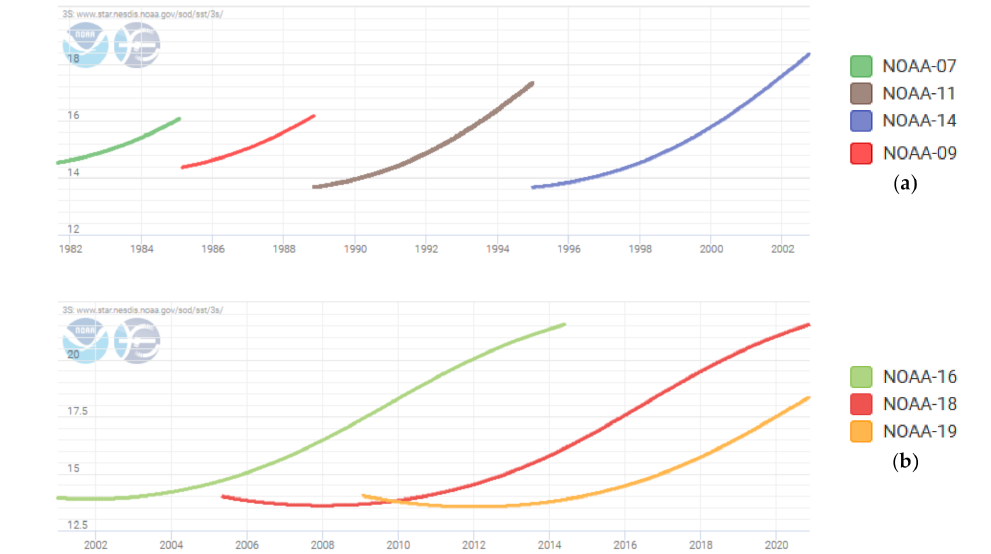
Figure 2. Equator crossing times for National Oceanic and Atmospheric Administration (NOAA)-7, NOAA-9, NOAA -11, and NOAA-14 platforms ( a ) and NOAA-16, NOAA-18, and NOAA-19 platforms ( b ), as retrieved from https://www.star.nesdis.noaa.gov/socd/sst/3s/ (accessed